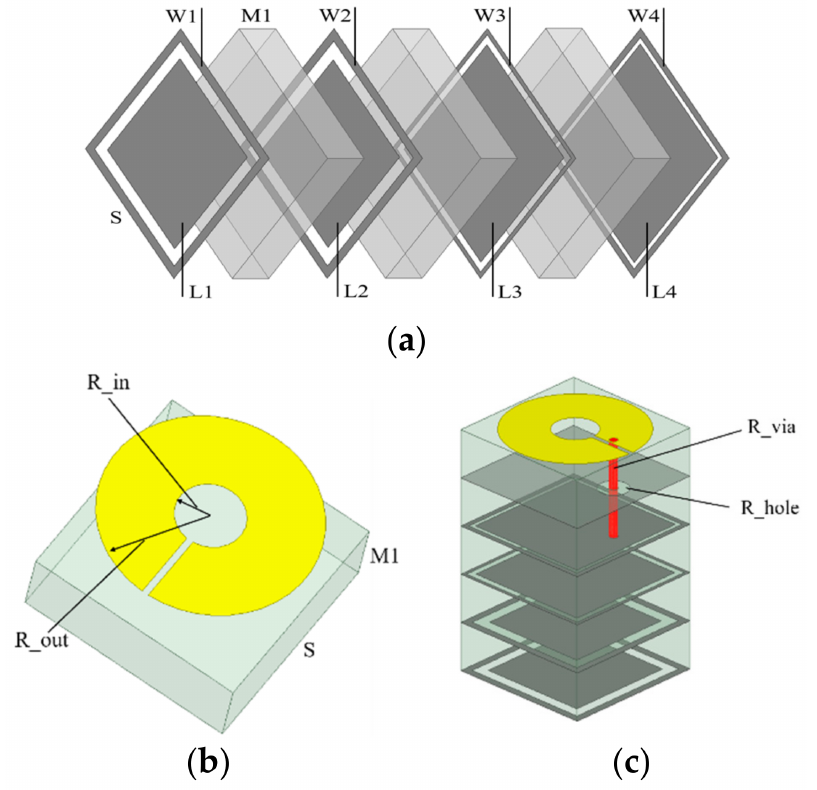
Figure 1. Schematic diagram of the proposed lens element: ( a ) phase modulation part; ( b ) polarization modulation part; ( c ) 3D view. Table 1. Geometric parameters of the nine unit